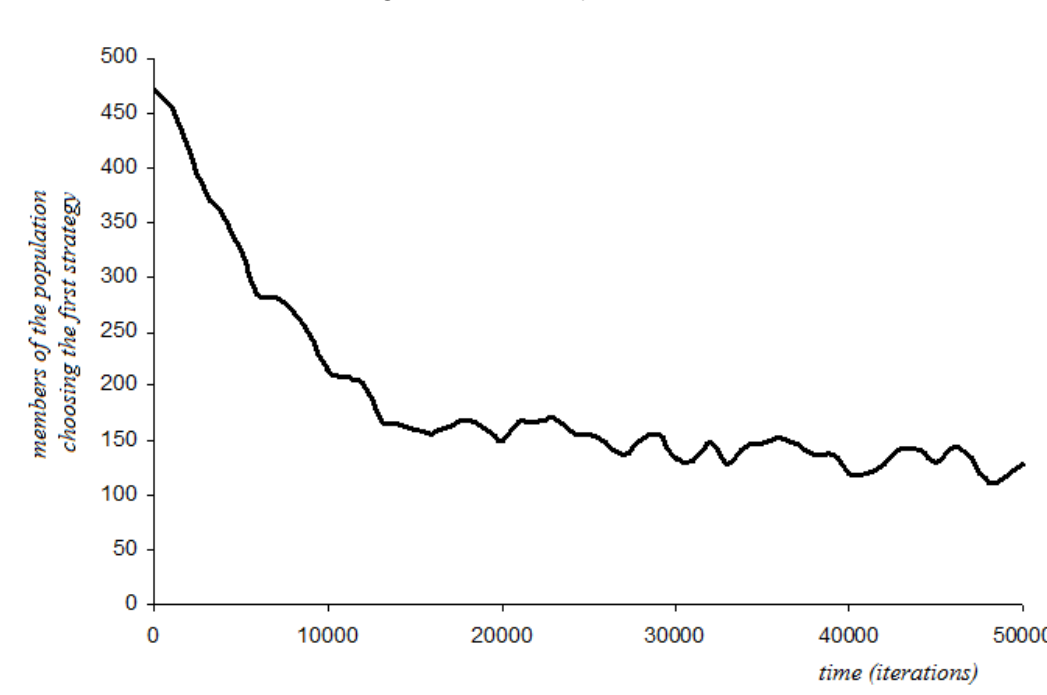
Figure 12. ‘ Stag-Hunt #3’ with p